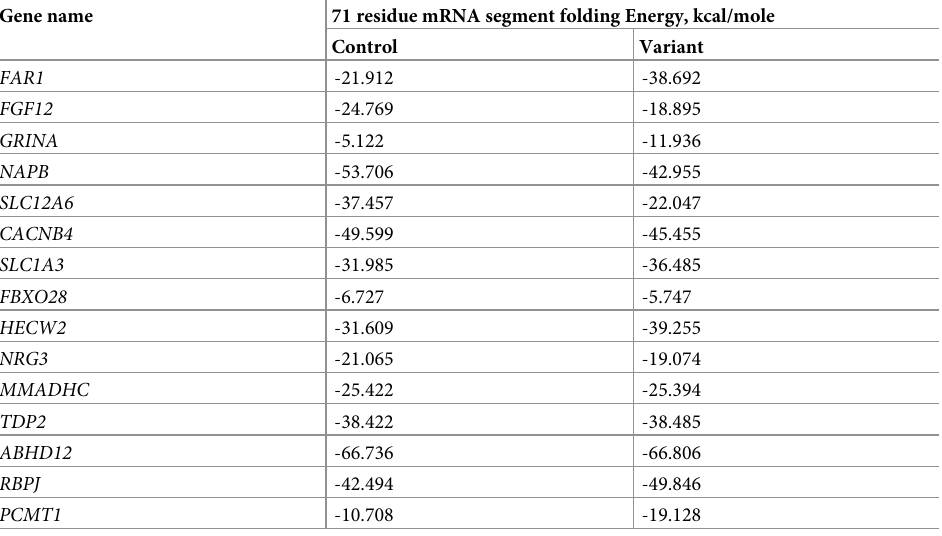
Table 3. Folding energy of the 71 residue 3’-UTR segments with and without the